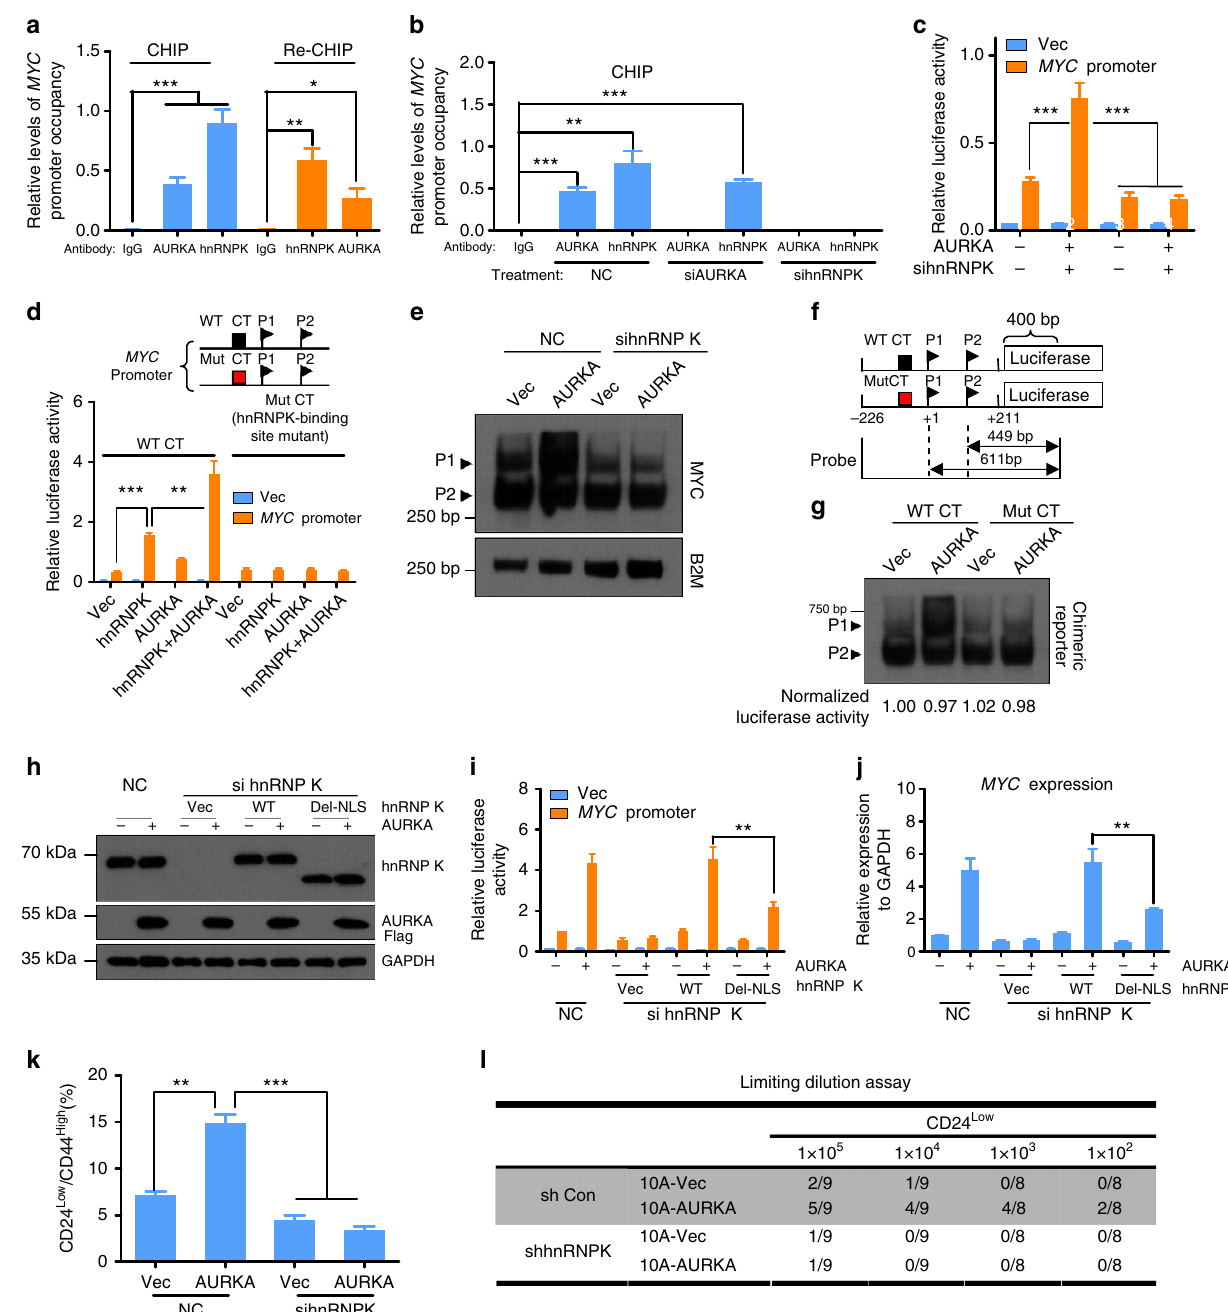
Figure 4 | hnRNP K is required for AURKA to activate MYC transcription and enhance BCSC phenotype. ( a ) Chromatin from MDA-MB-231 cells was extracted for ChIP and re-ChIP analysis. Results were normalized by input. ( b ) MDA-MB-231 cells were transfected with siRNA against negative control (NC), AURKA or hnRNP K for 48h. ChIP assays were performed. ( c ) MDA-MB-231 cells overexpressing HA-tagged AURKA were transfected with hnRNP K or NC siRNA. After 24h, cells were transfected with MYC promoter reporter (MYC) or basic reporter (Vec) along with pRL-TK for another 24h. Dual-luciferase reporter assay was performed. ( d ) Mutated reporter along with pRL-TK were co-transfected with AURKA or/and hnRNP K plasmids for 24h. Dual-luciferase reporter assay was performed. ( e ) 293T cells overexpressing HA-AURKA were transfected with hnRNP K or NC siRNA for 48h. S1 nuclease protection assay (SNPA) was performed to monitor MYC P1 and P2 transcripts. ( f ) Structure of chimeric gene consists of firefly luciferase and MYC promoter ( (cid:3) 226/ þ 211) (upper panel). Lower panel shows probes used for SNPA. ‘CT’ represented CT element. The mutant chimeric gene was mutated at hnRNP K-binding site. ( g ) Chimeric gene or its mutant were co-transfected with AURKA and pRL-TK plasmids into 293Tcells for 24h. SNPA was performed using the probes shown in f . In parallel, a fraction of these cells was evaluated for Renilla luciferase activity, which reflects the transfection efficiency. ( h , i , j ) 293Tcells were transfected with hnRNP K siRNA for 24h. Cells were then co-transfected with WTor NLS-deleted hnRNP K, AURKA and MYC promoter or basic reporter along with pRL-TK for another 24h. Transfected cells were harvested for immunoblotting (IB) ( h ), dual-luciferase reporter ( i ) and real-time PCR ( j ) analysis. ( k ) MCF-10A cells overexpressing HA-AURKA were transfected with hnRNP K or NC siRNA. After 48h, cells were collected to analyse CD24/CD44. ( l ) hnRNP K was knocked down in AURKA-overexpressing or control 10A-K-Ras (G12V) cells. Cells were sorted according to CD24 expression. CD24 Low population was used to perform limiting dilution assays. Bar represented the means ± s.e.m. of three independent experiments (analysis of variance (ANOVA) followed by least significant difference (LSD) test; * P o 0.05, ** P o 0.01, *** P o